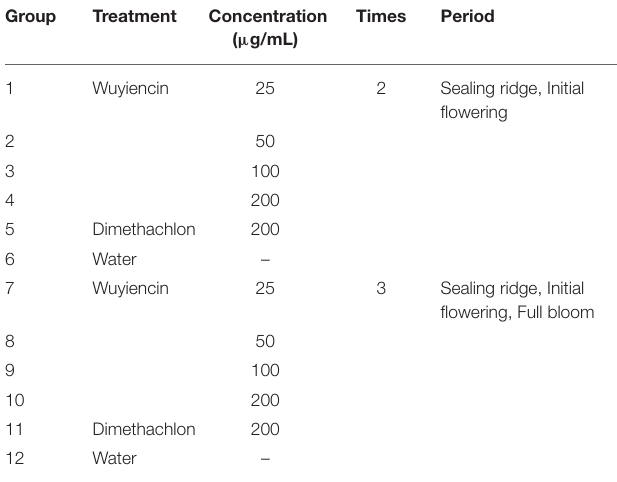
TABLE 1 | Treatments and experimental design.